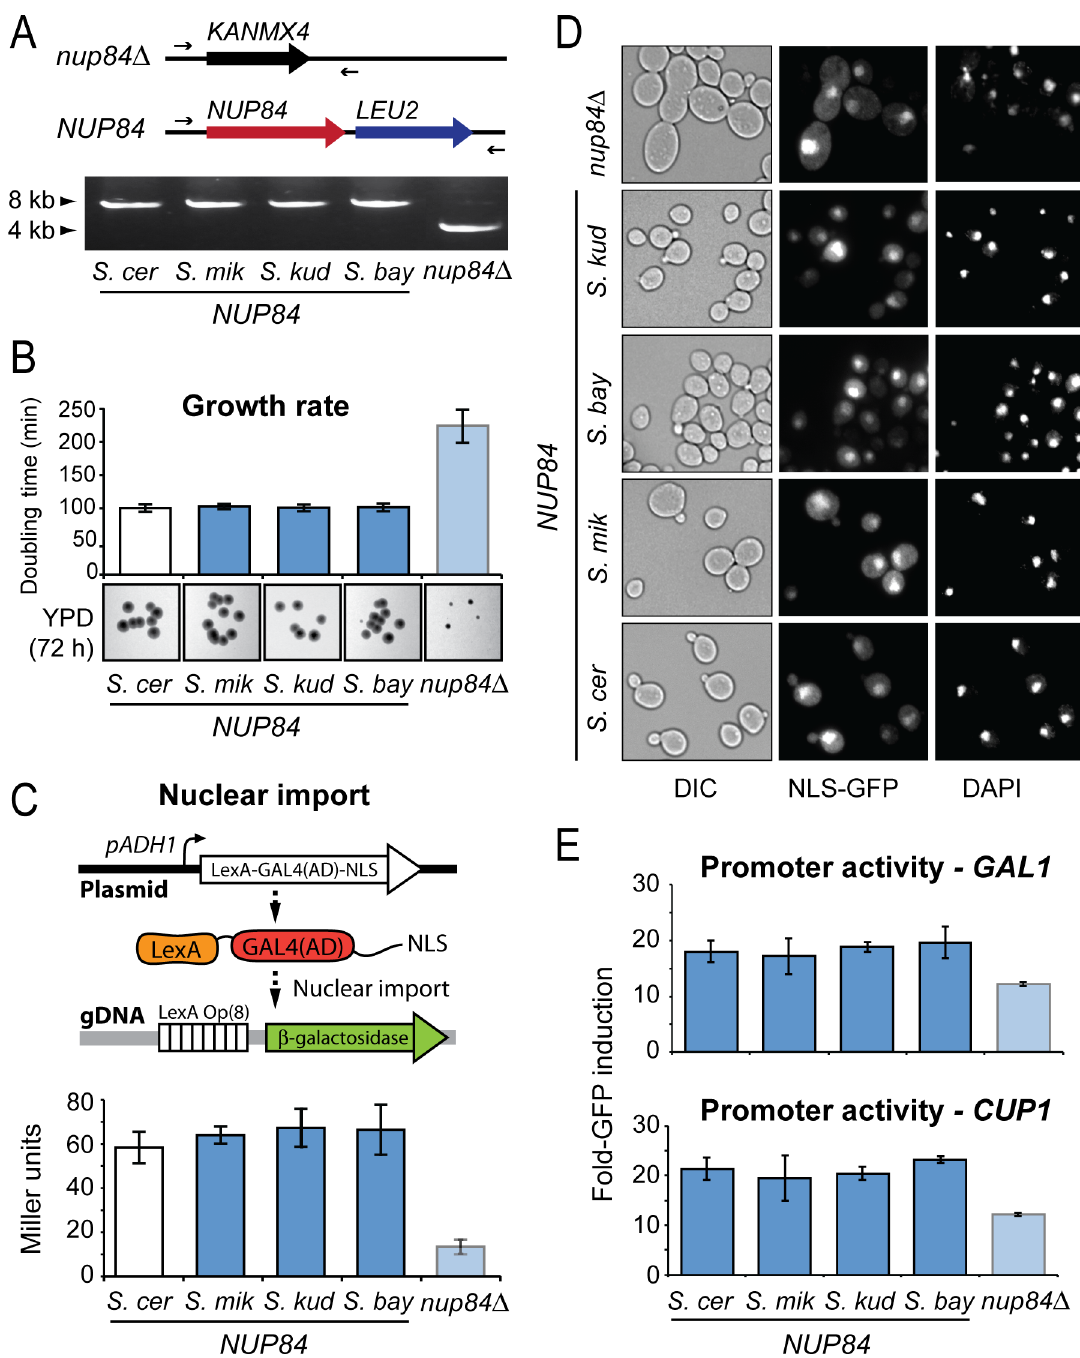
Fig 4. The housekeeping functions of NUP84 are conserved across divergent Saccharomyces species. (A) Top . A schematic representation of the NUP84 locus within S . cerevisiae engineered to either lack NUP84 ( nup84 Δ ) or to express heterospecific NUP84 from S . cerevisiae ( S . cer ), S . mikatae ( S . mik ), S . kudriavzevii ( S . kud ) or S . bayanus ( S . bay ) along with the LEU2 selectable marker. Bottom . Successful genome engineering was confirmed by PCR amplification across the NUP84 locus to detect the replacement of KANMX4 with NUP84-LEU2 (primers marked as arrows). (B) The doubling time of NUP84 -complemented strains in a liquid YPD medium compared to nup84 Δ ,and colony growth and morphology after 72 h of growth on a solid YPD medium. (C) General nuclear import function was assessed in the presence of heterospecific Nup84p or absence of Nup84p using a LexA-Gal4(AD) reporter protein with a SV40 nuclear localization signal (NLS) [71]. The LexA DNA binding domain and Gal4 activation domain (AD) initiate transcription of the β -galactosidase gene upon successful nuclear import. (D) Nuclear transport was also assessed by the